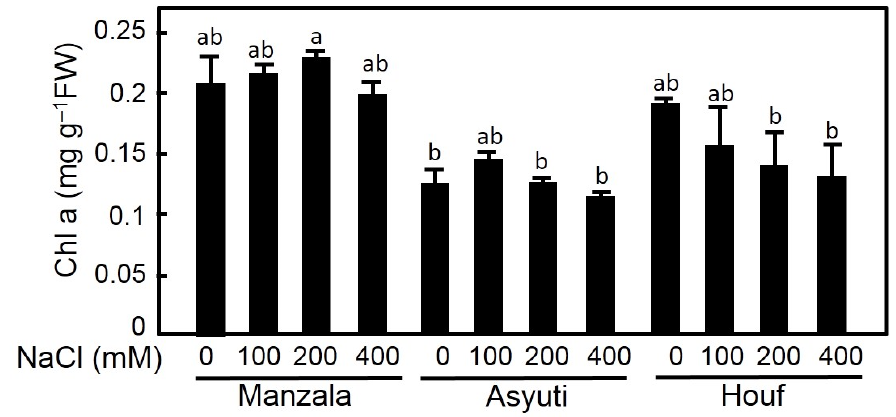
Figure 7. Effects of 45 days salt treatments (0, 100,200 and 400 mM NaCl) on chlorophyll a in Z. coccineum from Manzala, Wadi Asyuti and Wadi Houf. Value represents the mean of 3 replicates ± standard error, p -value <0.05. For variables denoted with the same letter, the difference is not statistically significant.